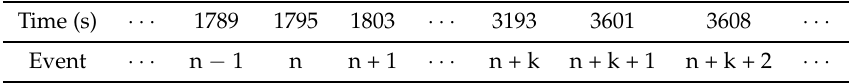
Table 10. An imagined sequence of price change events before the second thirty minute window has been removed.